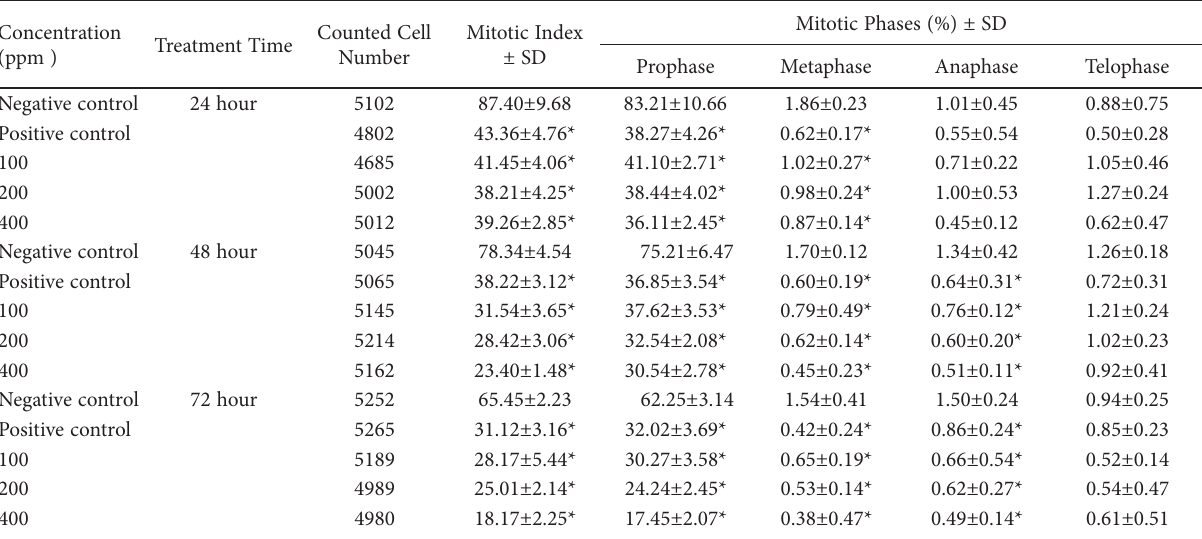
Table 3. The effects of Napoleon 4EC on MI and mitotic phases in the root cells of A. cepa.